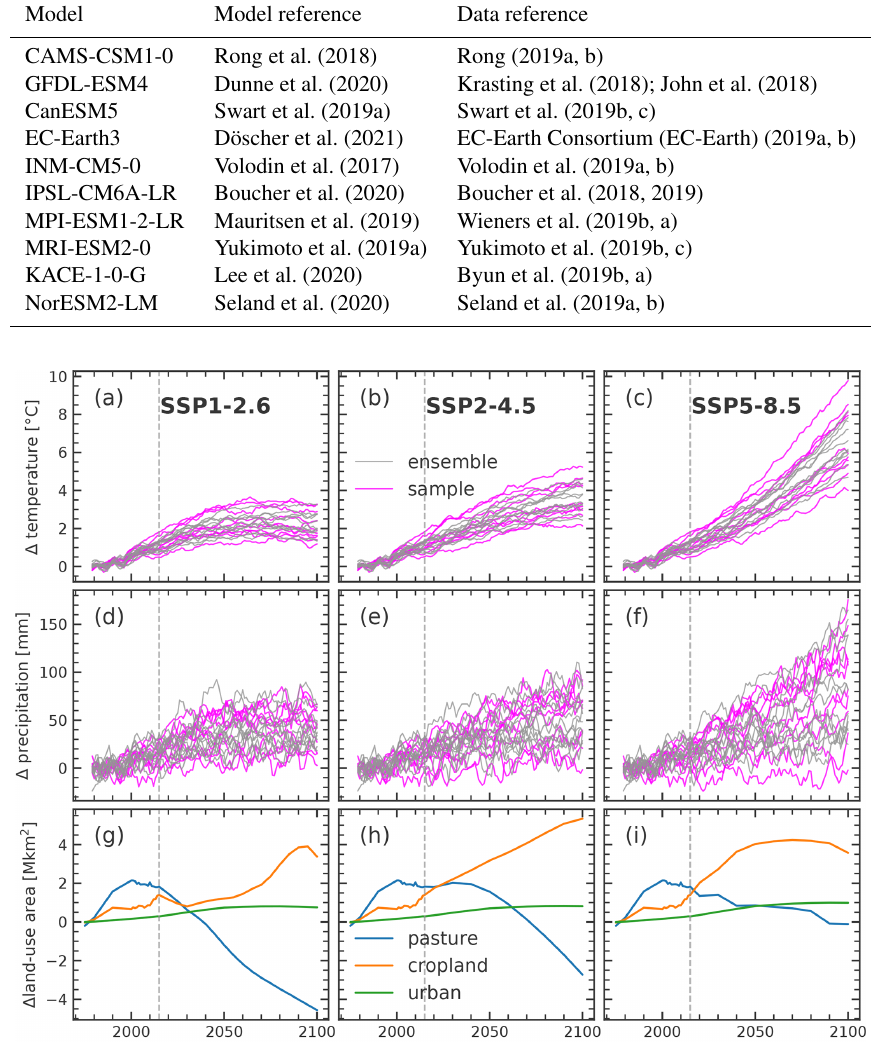
Figure 2. Global surface air temperature (a–c) , precipitation (d–f) , and land-use area (g–i) anomalies for the 1961-1990 average for three CMIP6 scenarios: SSP1-2.6 (a, d, g) , SSP2-4.5 (b, e, h) , SSP5-8.5 (c, f, i) . Magenta lines show anomalies of the climate model ensemble subset applied to force LPX-Bern versus the rest of the CMIP6 ensemble in gray. Dashed vertical gray lines show the year 2015 from which the future scenarios diverge. Pasture, cropland, and urban land-use areas amount to 31.2, 14.4, and 0.3Mkm 2 during the 1961–1990 baseline period